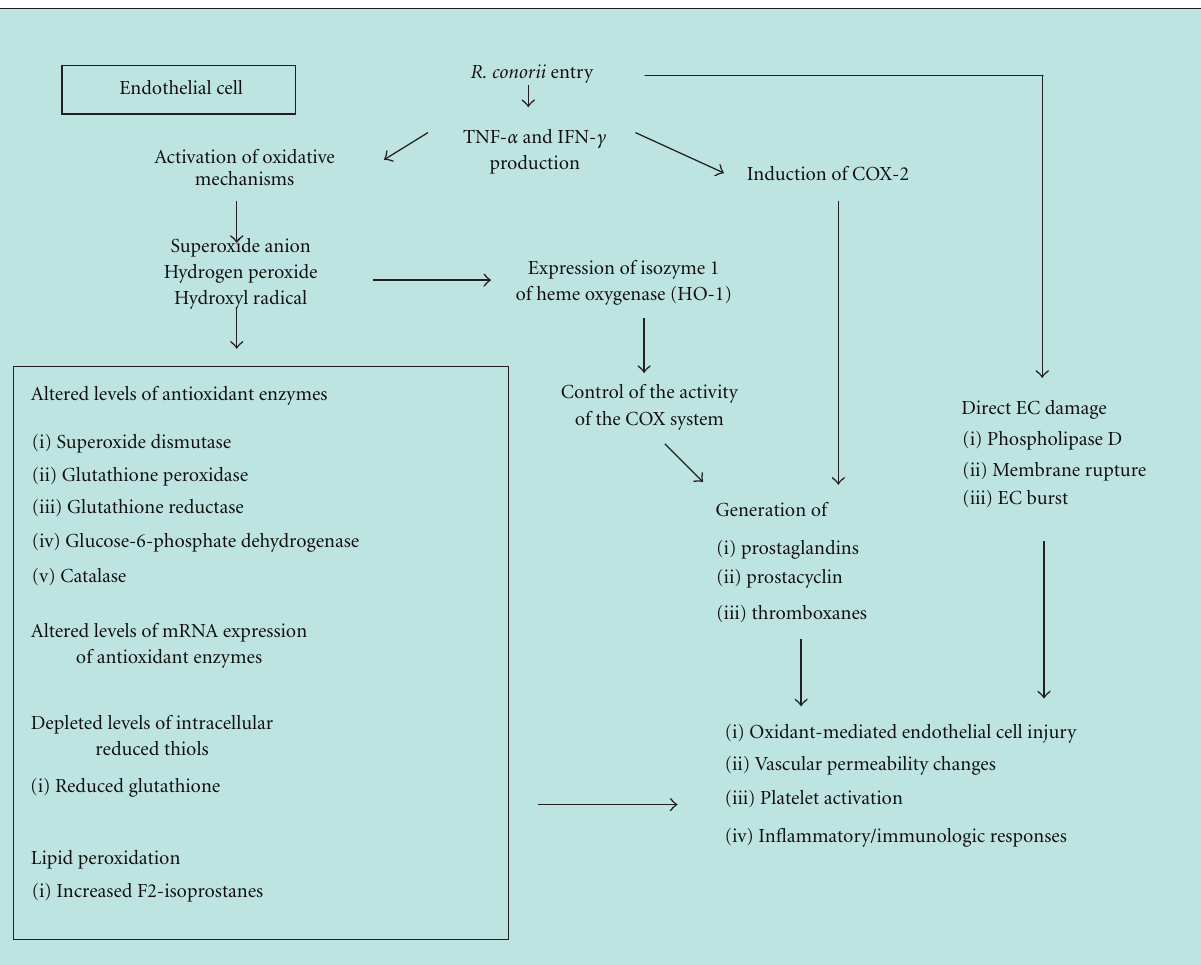
Figure 2: Rickettsia injury to endothelial